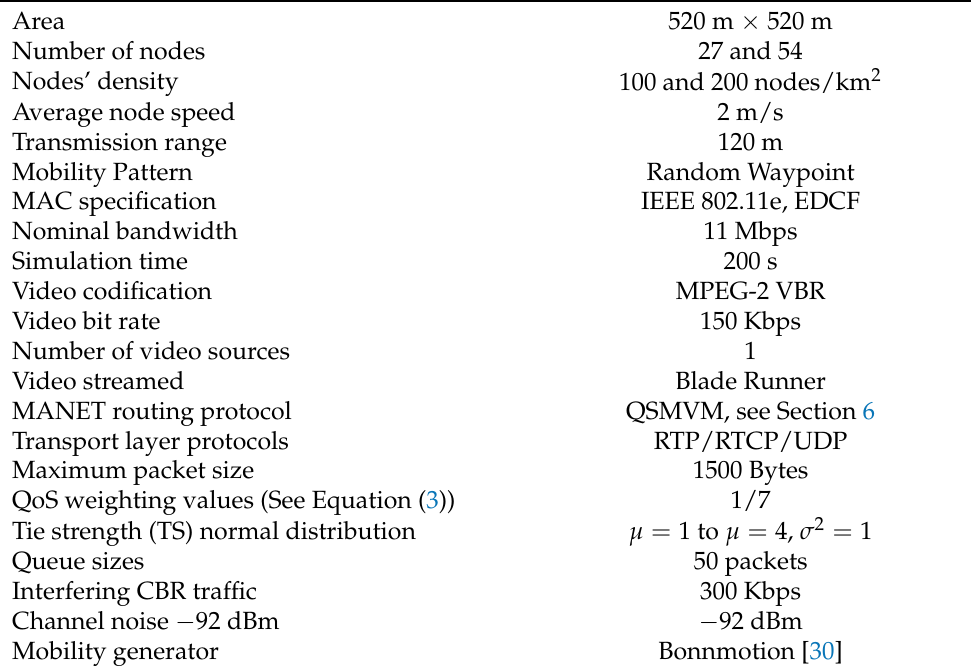
Table 3. Simulation settings of the scenarios